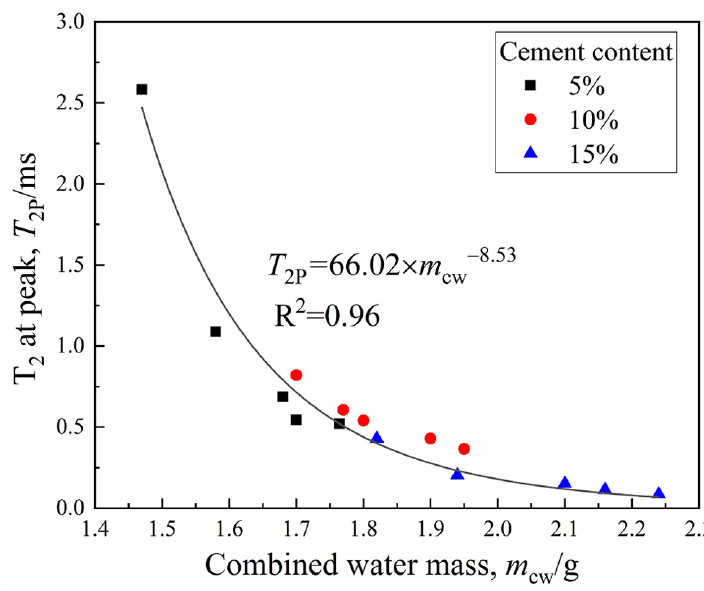
Figure 6. Cement hydration model established by Wang [27] and Dong [28].